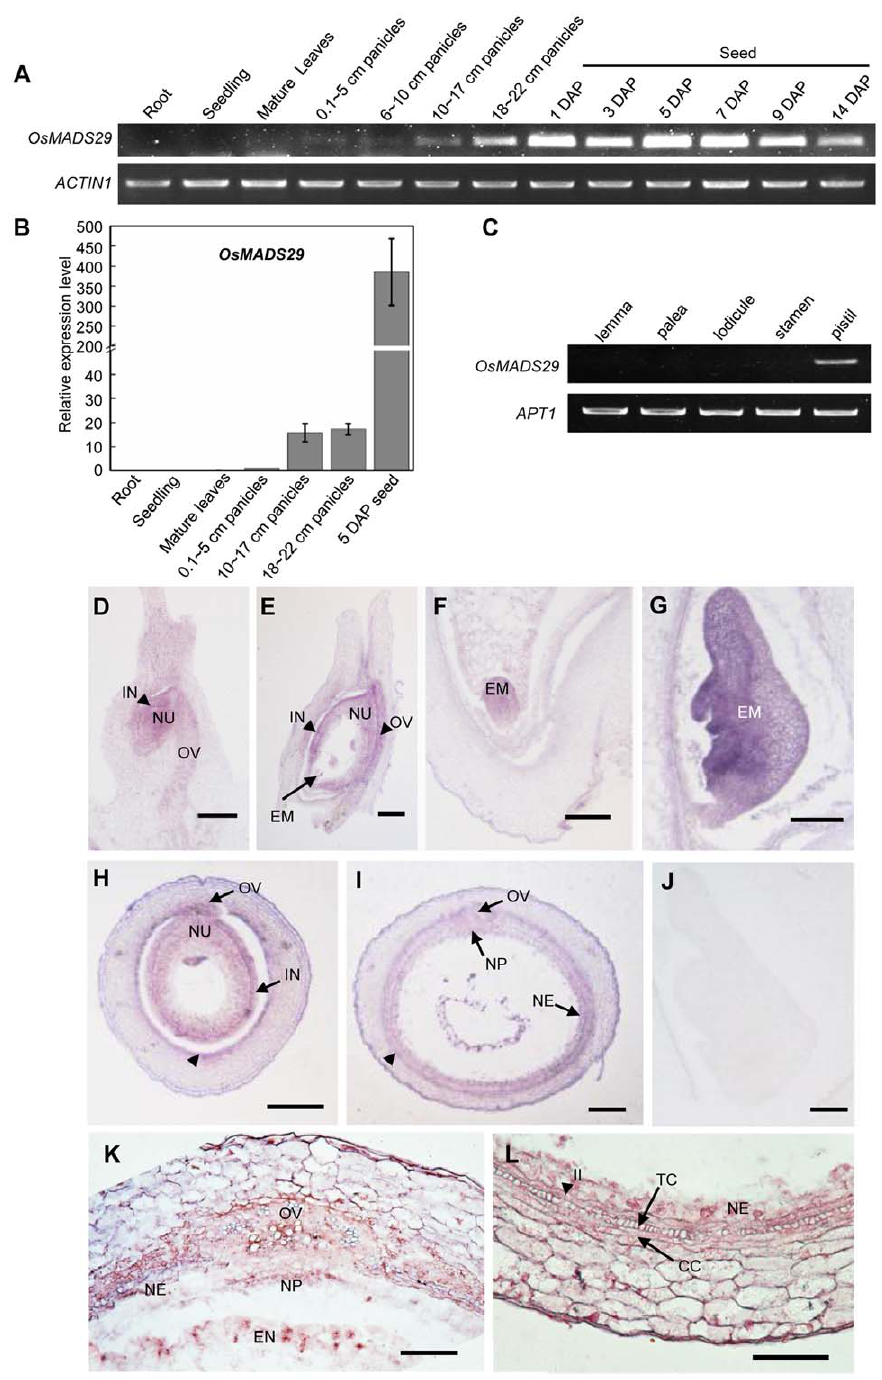
Figure 2. Expression analyses of OsMADS29 . (A). RT-PCR analyses of OsMADS29 expression at different developmental stages of wild type plants. DAP, days after pollination. ACTIN1 was used as control. (B). Relative expression levels of OsMADS29 at different developmental stages. Amounts of transcripts are shown as relative values to those of UBQ . Error bars show SD (n=3). (C). RT-PCR analyses of OsMADS29 expression in various floral organs of wild type plants at heading date stage. APT1 was used as a control [47]. (D–L). In situ hybridization analyses of OsMADS29 in ovules and developing seeds. (D). Longitudinal section of the ovule. (E–G). Longitudinal sections of seed at 1 DAP (E), and embryo of seed at 3 DAP (F) and 5 DAP (G). (H–I). Transverse sections of the mid-region of the ovary at a few hours before anthesis (H) and seed at 3 DAP (I). The arrows head in (H) and (I) indicate the inner layer cells of the pericarp. (J). Negative control with sense probes of OsMADS29 . (K–L). A magnification of the transverse section of a seed at 7 DAP. (K). The ovular vascular trace in the seed at 7 DAP. (L). Part of pericarp of seed at 7 DAP. CC, cross-cells; EM, embryo; EN, endosperm; IN, integuments; II, inner layer of the inner integument; NE, nucellar epidermis; NP, nucellar projection; NU, nucellus; OV, ovular vascular trace; TC, tube-cells. Bars=100 m m in (D) to (J), and 50 m m in (K) and (L).